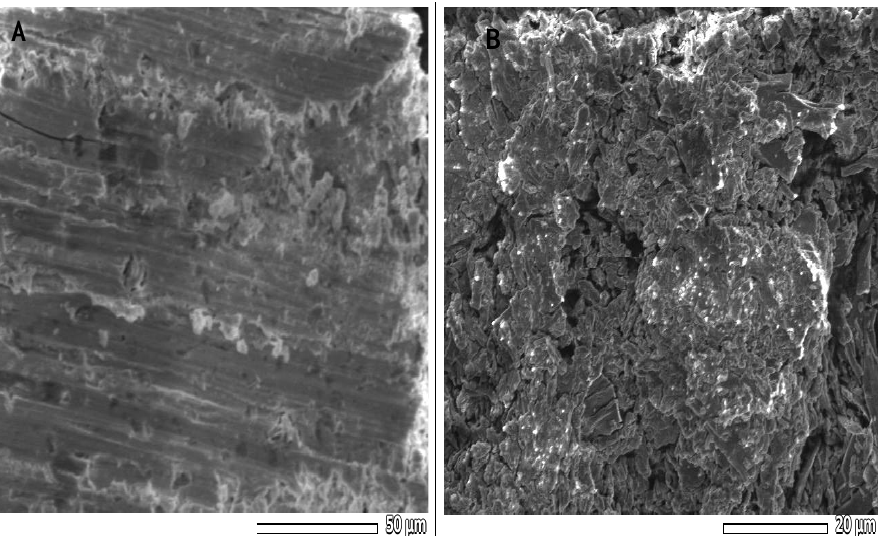
Figure 4. SEM micrographs of ( A ) control membrane and ( B ) optimized membrane used for sensing mercury (II).